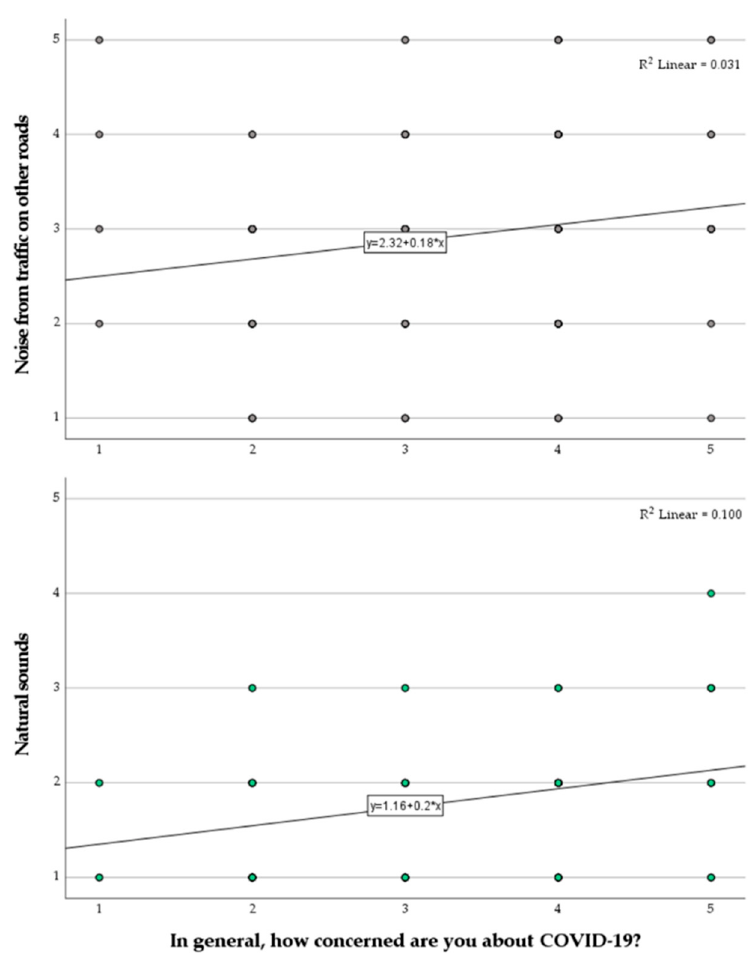
Figure 8. Perceived dominance of “Noise from traffic at other roads” ( top ) and “Natural sounds” ( bottom ), as a function of the scores for the item “In general, how concerned are you about COVID- 19?” (1–5; Not at all–Very much).